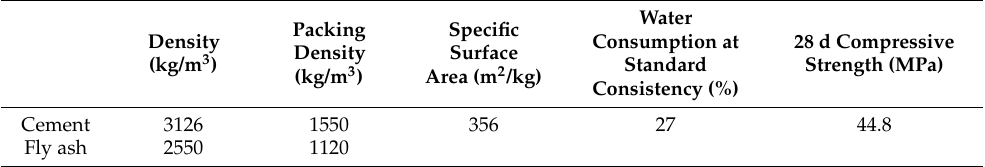
Table 1. The physical properties of binder materials.